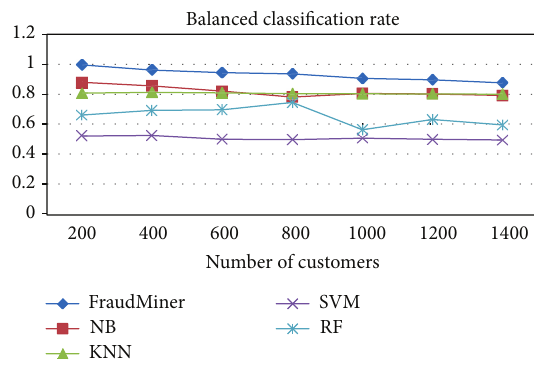
Figure 4: Performance comparison of classifiers on balanced classification rate.